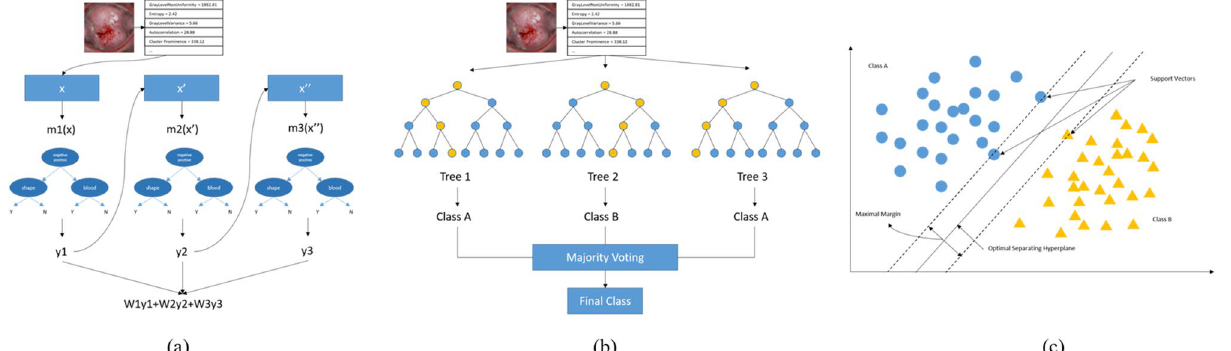
Figure 2. The diagrams of ML model architectures for cervical cancer classification. ( a ) In XGB, the y value extracted from one feature is used as an input value to predict the next feature, and the final y values after this process are combined with the weights. ( b ) RF creates several decision trees and synthesizes the results of each tree to determine the final class. ( c ) After linearly classifying the data, SVM finds the boundary with the largest width through an